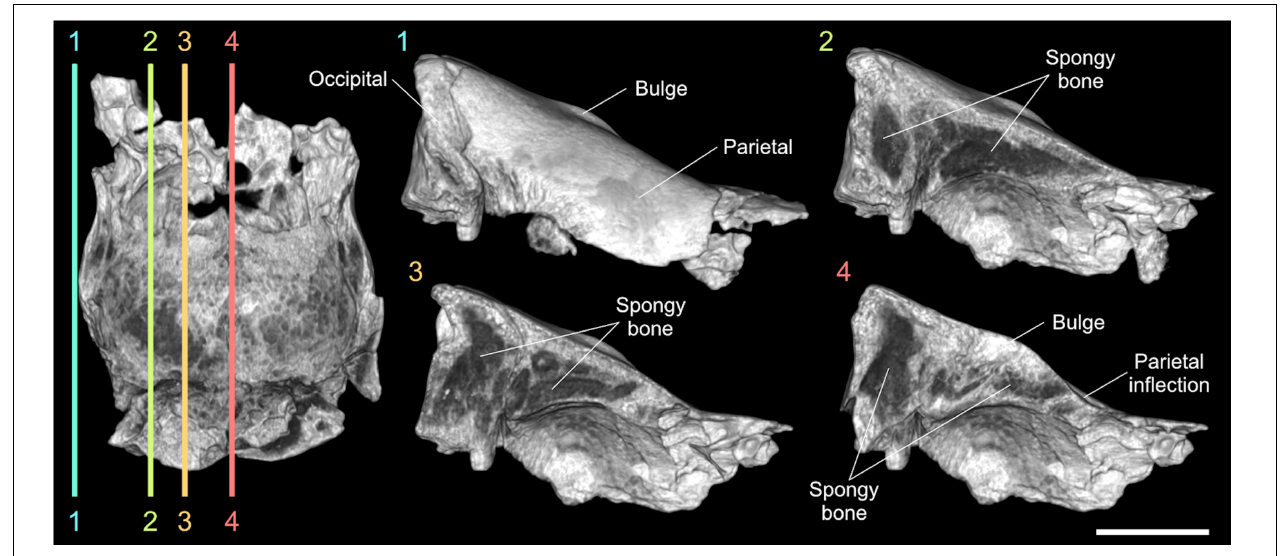
FIGURE 4 | Digital longitudinal sections of the braincase MPND1082 in right lateral view. The dark-gray areas indicate the spongy bone tissue. Sale bar 5